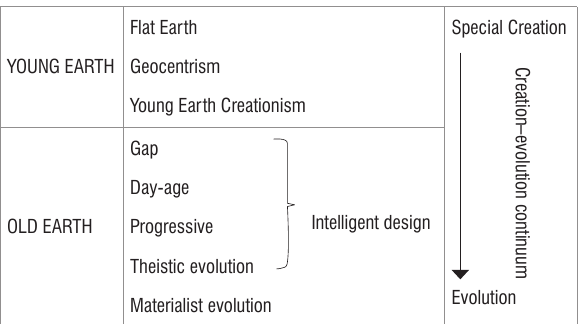
EARTH Intelligent